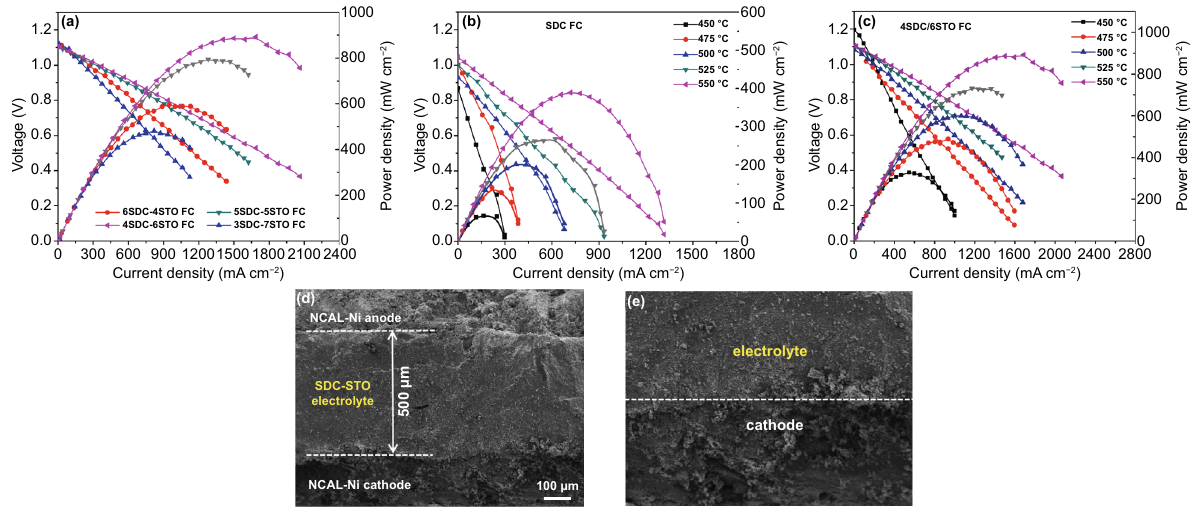
Fig. 4 Electrochemical performance of a the SDC–STO SOFCs with various compositions at 550 ℃ , b the SDC SOFC from 450 to 550 °C, and c the SOFC using optimal 4SDC–6STO from 450 to 550 °C. d Cross-sectional SEM image of the 4SDC–6STO fuel cell and e the electrolyte/ cathode